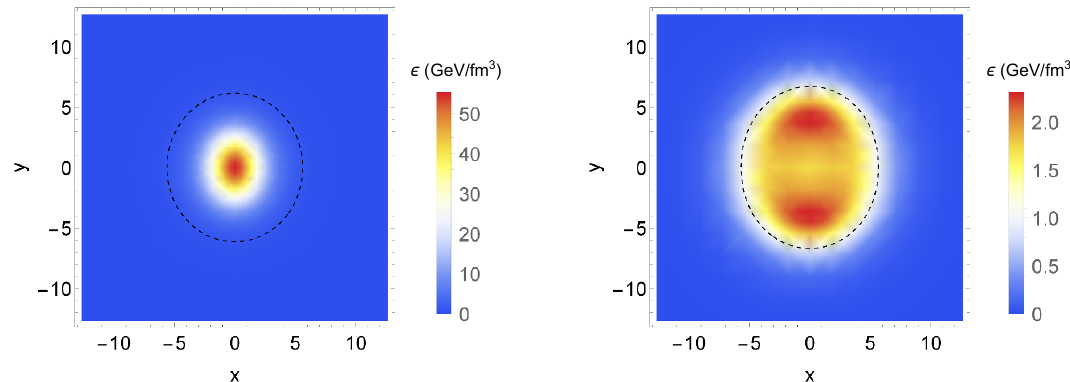
Figure 1 . (color online). Energy density in y (cid:0) (cid:17) plane from eq. (2.29) using parameters (cid:12)xed in (6.4) for ! 1 = 0 : 5 ; ! 2 = 0 : 05 at (a) (cid:28) = 0 : 4 fm = c and (b) (cid:28) = 5 fm = c. The dashed line is the contour of (cid:15) = 1 GeV = fm 3 .